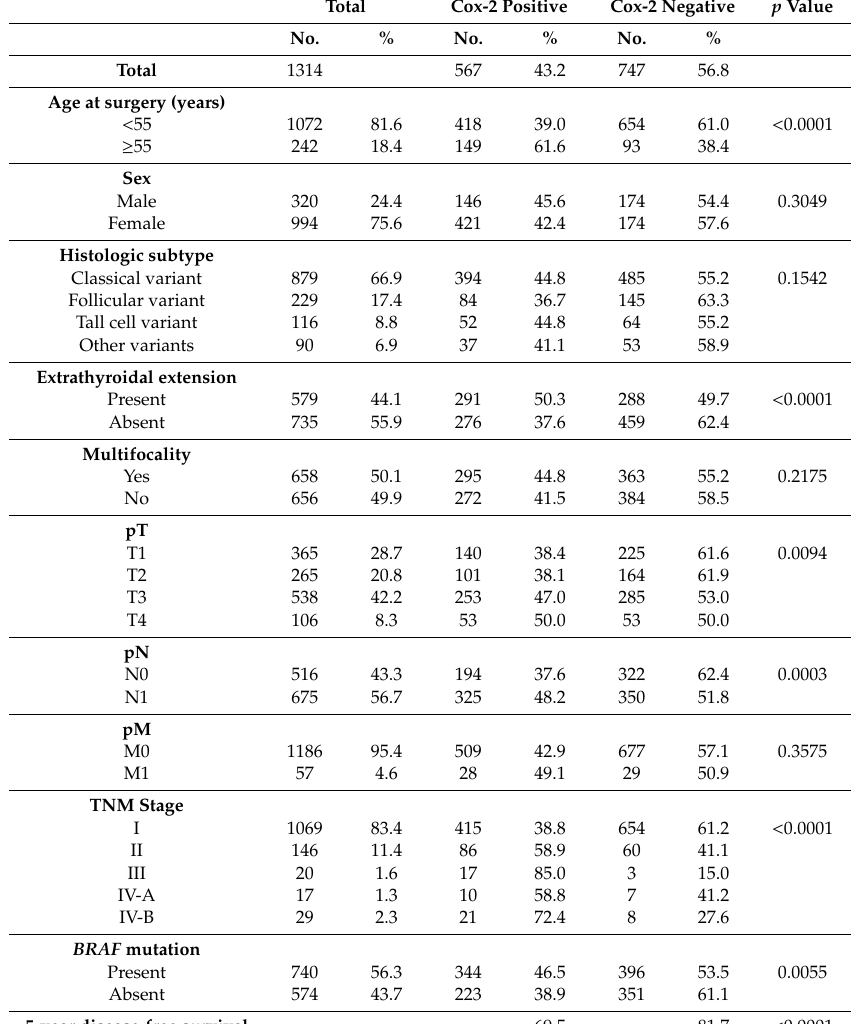
Figure 1. Cyclooxygenase-2 (COX-2) immunohistochemical staining in papillary thyroid carcinoma (PTC) tissue microarray (TMA). Representative examples of tumors showing ( A ) high expression and ( B ) low expression of COX-2 (20×/0.70 objective on an Olympus BX 51 microscope (Olympus America Inc., Center Valley, PA, USA), with the inset showing a 40×/0.85 aperture magnified view of the same TMA spot). Table 2. Association of clinicopathological characteristics with Cox-2 expression in PTC.